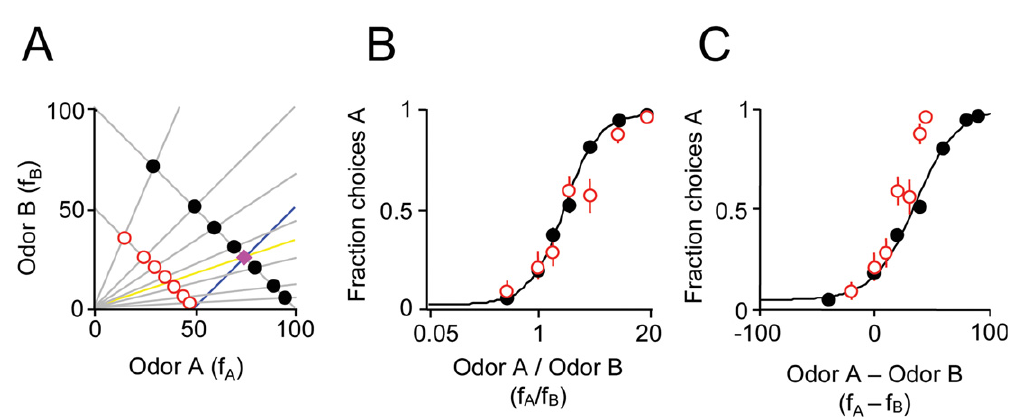
+ f = 100; black fi lled circles) A B = 3) while the blue line indicates the / f A B / f . (C) The same data as in (B) but where A B